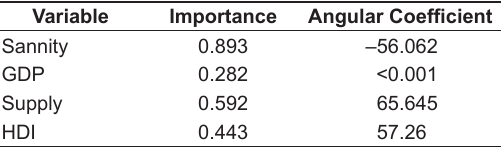
Table 2. Importance of each variable and the angular